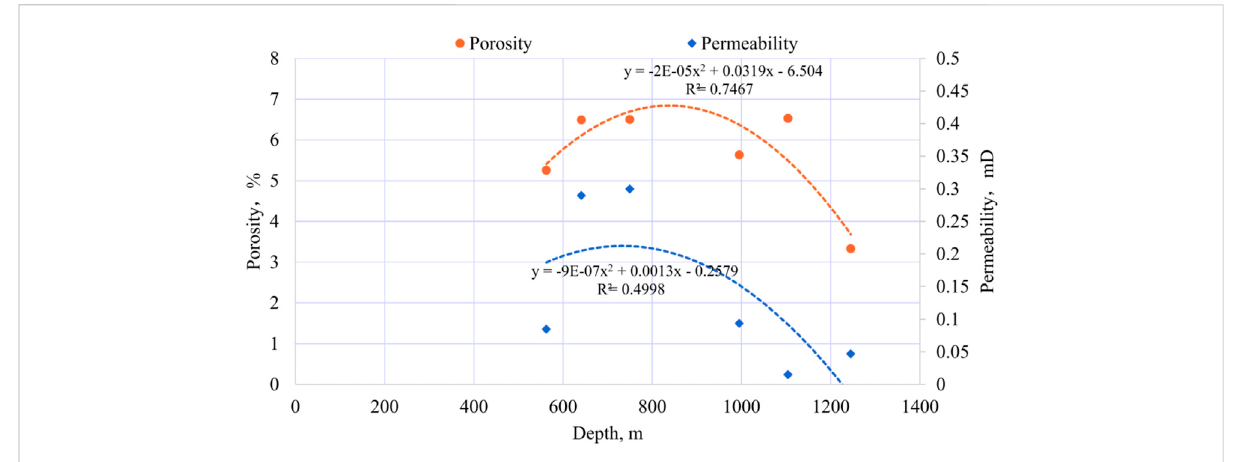
FIGURE 7 Porosity and permeability in relation to depth (Zhang, 2018).